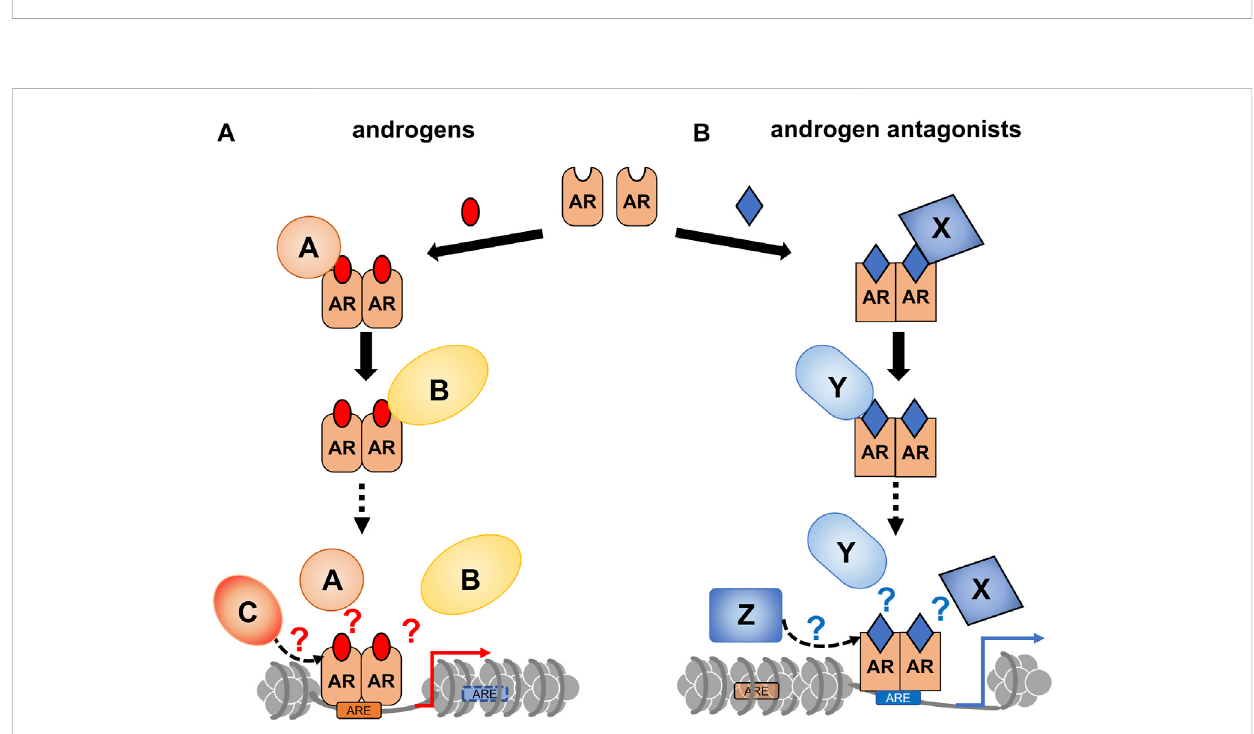
FIGURE 4 A schematic of androgen receptor (AR)-coregulator-mediated chromatin remodeling by ligand binding. A ligand type-speci fi c set of AR co- regulators facilitate ligandtype-speci fi cchromatin reorganization.AssociationsofARwithco-regulatorsaredifferentiallyinduced byAR ligands. Inorder to reorganize the chromatin environment, multiple co-regulators appear to be transiently and sequentially recruited for ligand-bound AR. (A) The canonical recruitment of co-regulators by androgen binding is depicted. (B) Androgen antagonists are potent to recruit non-canonical co- regulators, thereby leading atypical chromatin